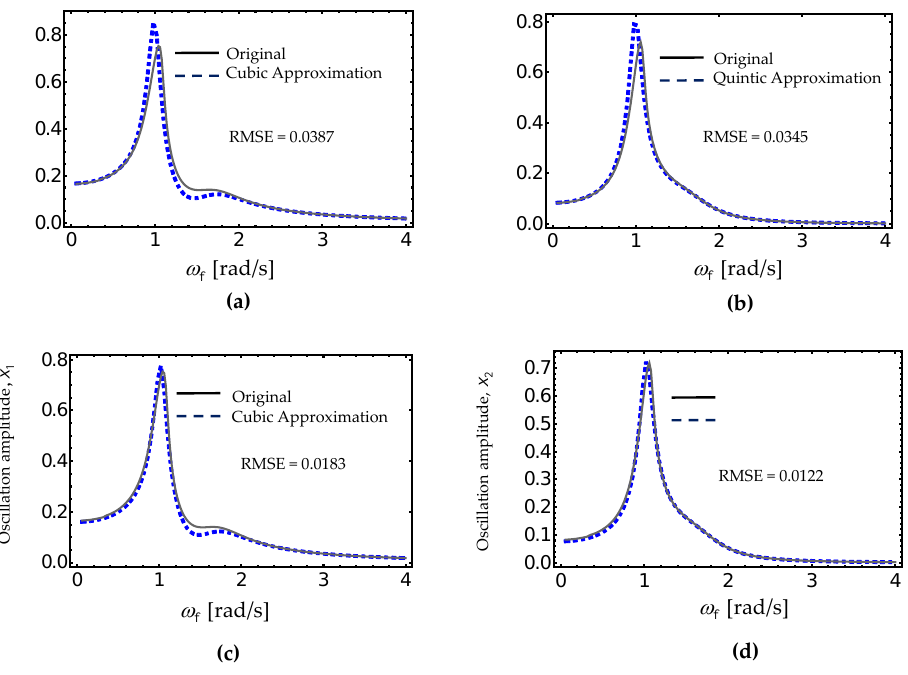
1 = 2.9995 , 𝑏 2 = 0.1228 , 𝑏 3 = 0.0008 , 𝜇 1 = 0.0807 , 𝜇 2 = −0.0206 , 𝜇 3 = 0.0066 , 𝜇 4 = 0.375 , 𝜇 5 = 0 , 𝜇 6 = 0 , with fitting parameter values of 𝜂 1 = 1 , 𝜂 2 = 0.3 , 𝑉 1 = 1 , 𝑉 2 = −0.15 , 𝜂 11 = −0.01 , 𝜂 22 = 1 , 𝑉 11 = 0 , 𝑉 22 = 1, and weighted mean square error values of U 1 = −2.16 × 10 −5 , U 2 = 0. Here, the black, solid lines describe the numerical integration solutions of Equation (30), while the blue, dashed lines represent the numerical solutions obtained from the nonlinear equations of motion, (53) and (54).